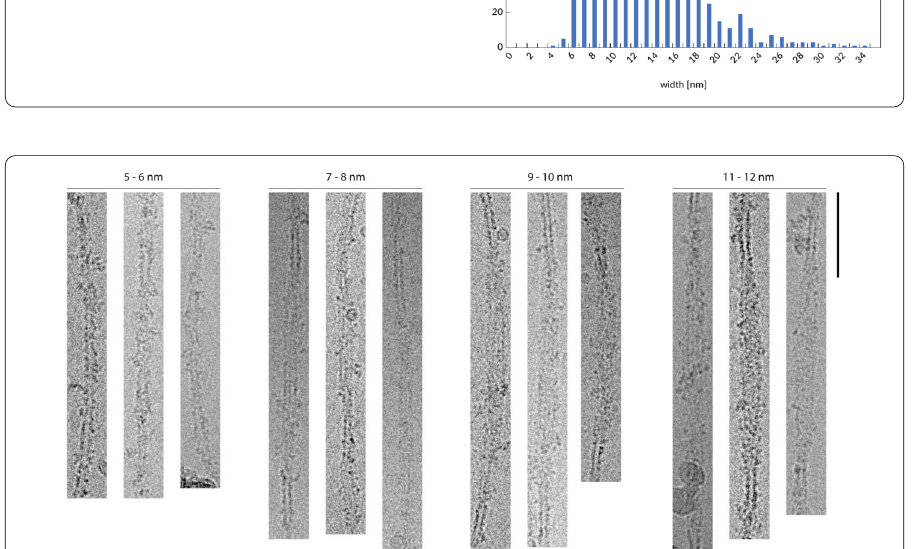
where | T ∩ S | is the area of the intersection of ground truth T and segmentation map S and | T | and | S | are their respective areas. A value of γ = 1 corresponds to T = S while a value of γ = 0 indicates that no pixel is classified correctly in the segmentation map. Applying the trained neural network to the retained test data yields a mean Sørensen-Dice coefficient of γ = 0.83, indicating a reliable binary